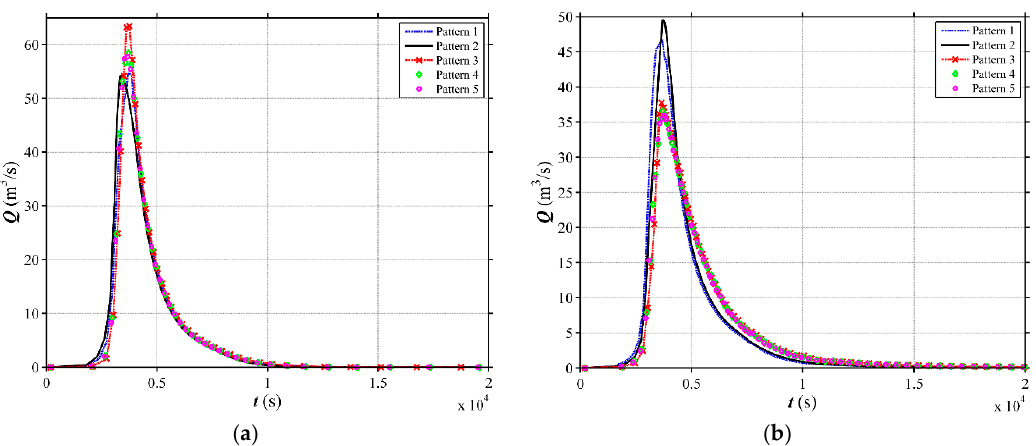
Figure 14. Simulated hydrographs at the outlet for different vegetation cover patterns of the V-shaped catchment under 100-year rainfall event (vegetation cover is 50%). ( a ) i 1 = 0.01, i 2 = 0.58; ( b ) i 1 = 0.08, i 2 = 0.58.